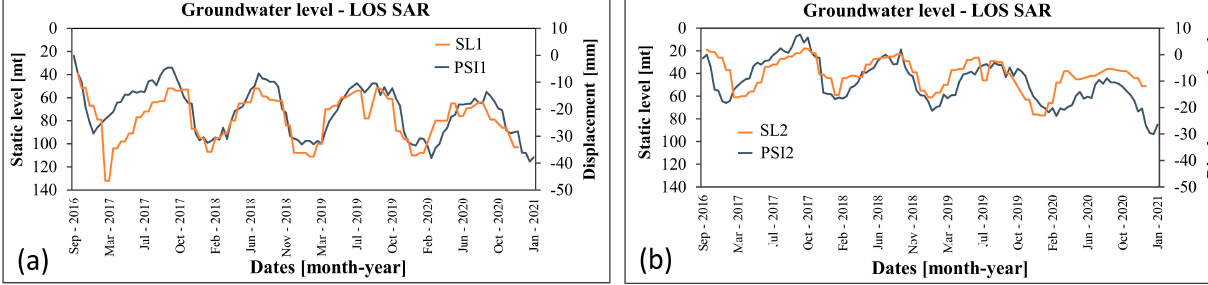
Figure 12. Groundwater level and LOS SAR time series, (a) SL1 and PSI1 for Well 1 (W1), and (b) SL2 and PSI2 for Well 2 (W2).